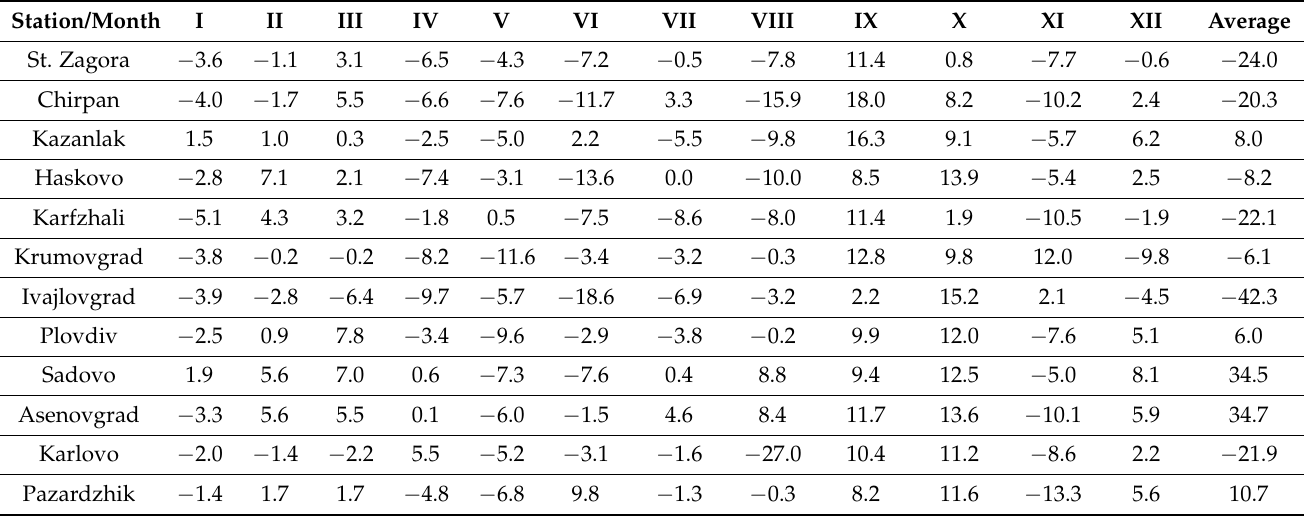
Table 10. Average monthly sums of rainfall deviations in central south Bulgaria in the period 1986–2015.